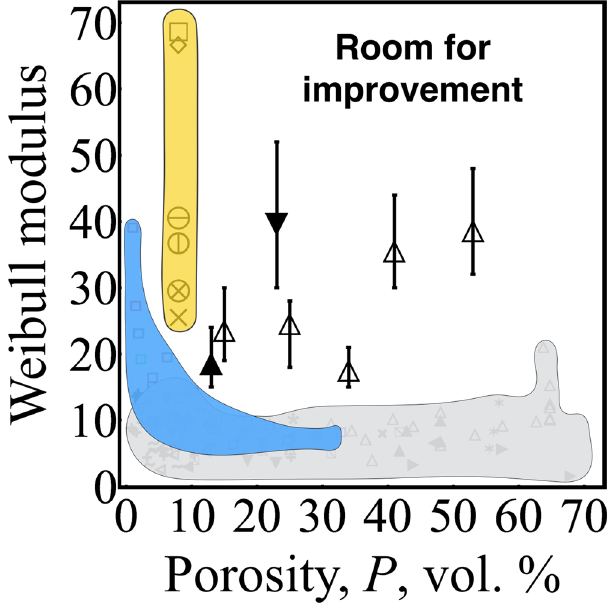
Figure 7. Effect of porosity on the Weibull modulus of FDMed-SCFR composites; Δ is for M1, ▲ is for material 2 at 100% infill, and ▼ is for M2 at 100% infill in 0° raster orientation. Error bars represent 90% confidence intervals. Yellow represents moduli of FDMed ABS built in different orientations 11 . Gray represents experimental moduli of various porous ceramics 52 . Blue represents simulated modulus of brittle porous materials 52 .